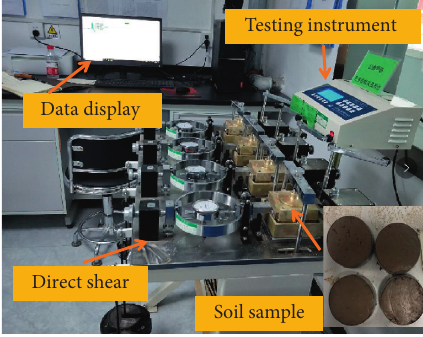
Figure 7: Conventional direct shear test. Table 2: Similar material parameters.